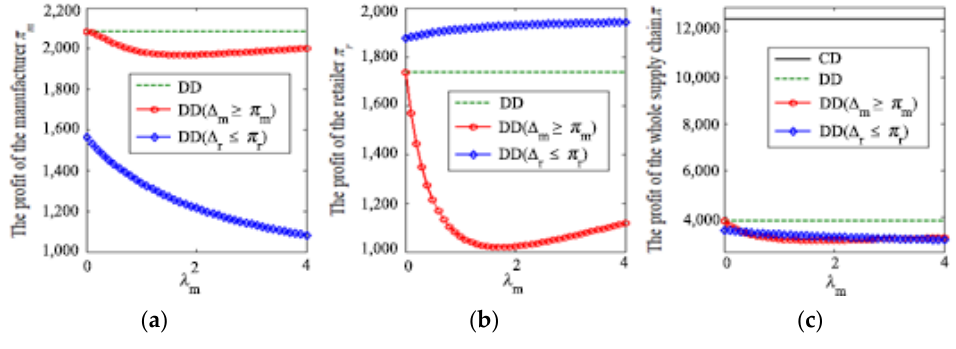
Figure 4. The effects of Signify’s levels of loss aversion on profits.